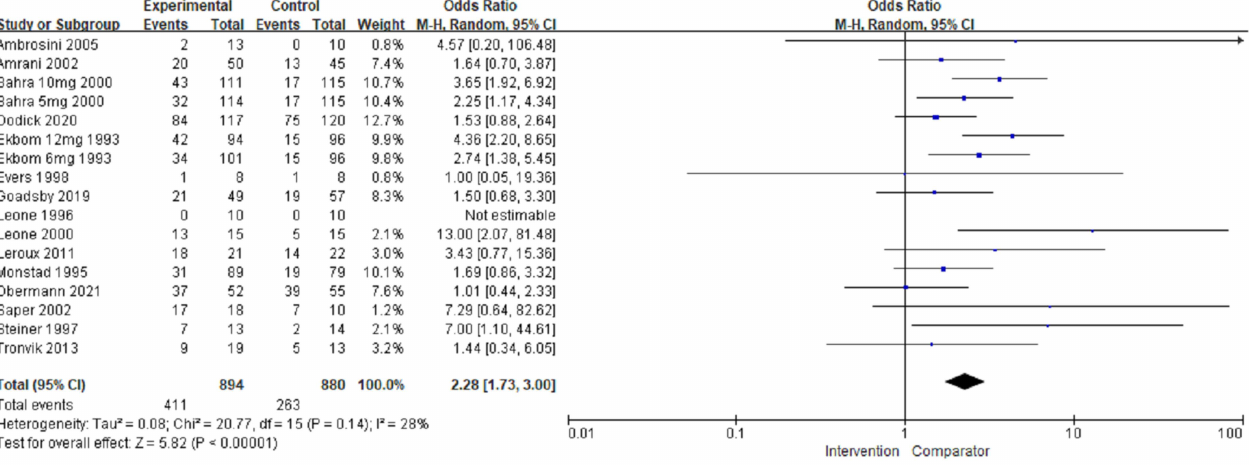
Figure 8. The overall effect of pharmacological treatment for the number of patients with adverse events compared to placebo. Blue squares indicated effect size for each of included studies and the size of blue square indicates the weight assigned to that study in the meta-analysis. Black diamond suggested as meta-analyzed measure of effect. Bold letters represented a category or subtotal of overall